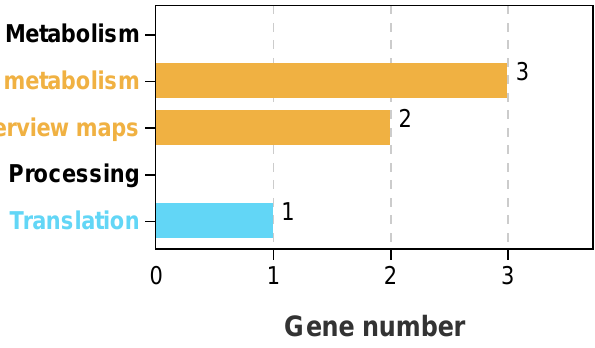
Figure 15. KEGG enrichment analysis of positive selection genes.